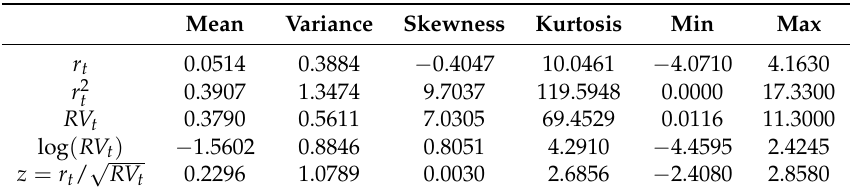
Table 1. Summary